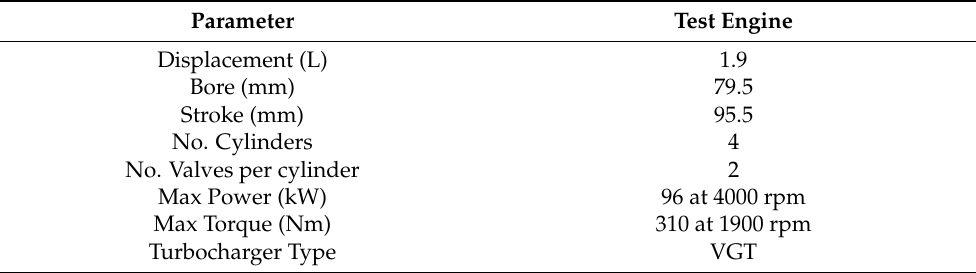
Table 2. Specification of the test